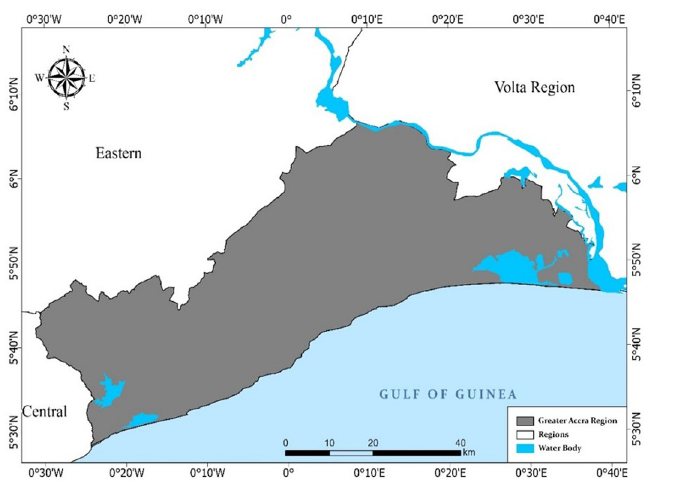
Fig 1. Map of the Greater Accra Region of Ghana. Source: